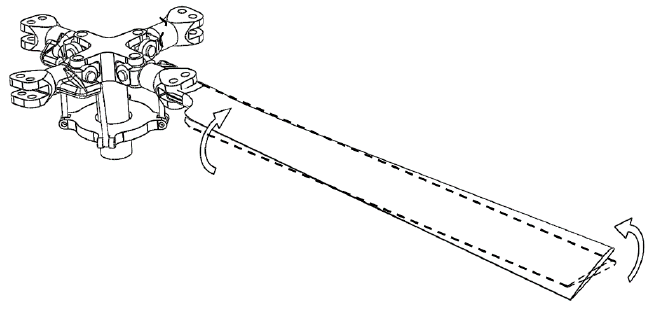
Figure 1. An illustration of the active twist rotor.